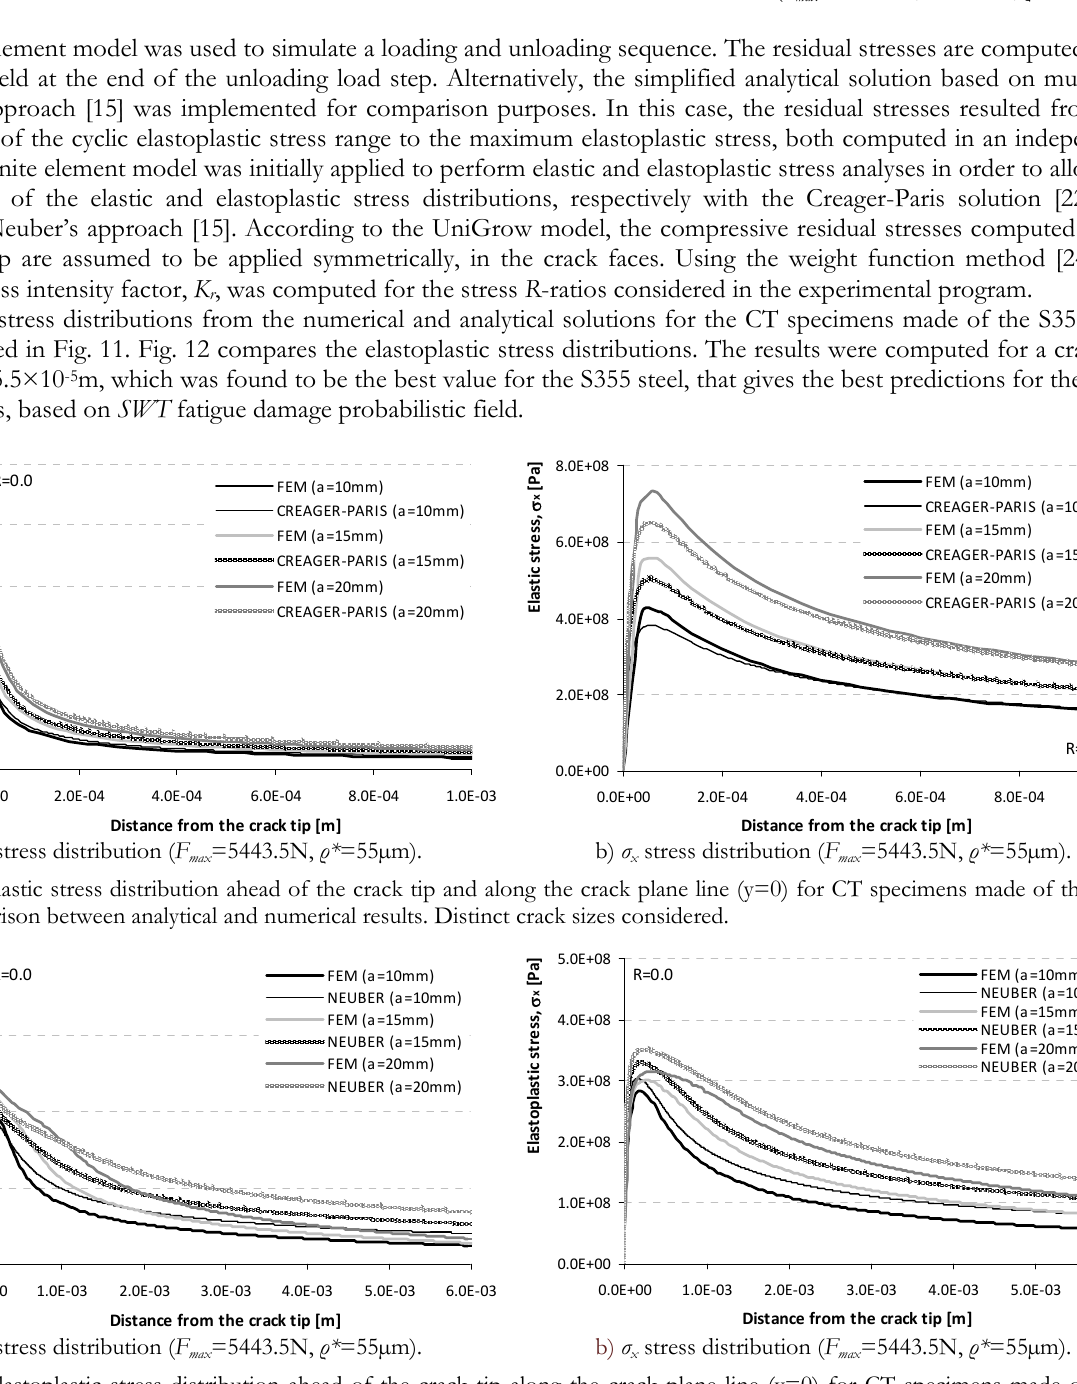
Table 3: Maximum elastic stresses for distinct finite element mesh densities for the S355 steel ( F